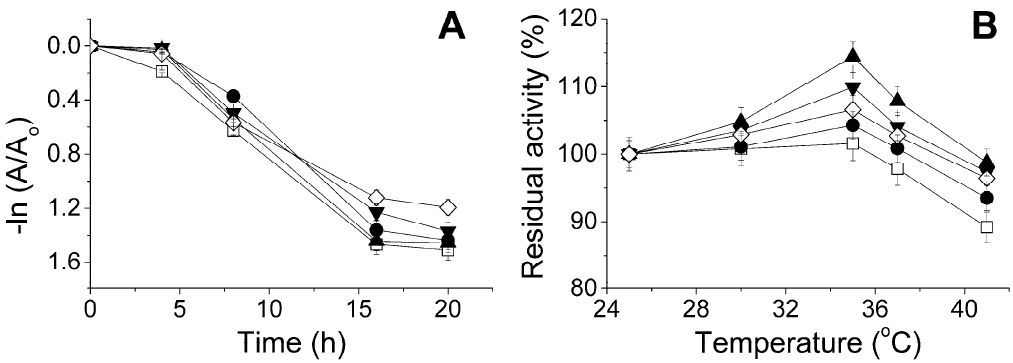
Figure 7. Thermal inactivation of lactonase activity of His 6 -OPH at pH 7.4 as a function of ( A ) time of exposure at 37 °C; and ( B ) temperature of the environment upon exposure for 15 min in the absence ( □ ) and presence of ampicillin ( ● ), gentamicin ( ▼ ), kanamycin ( ▲ ), and rifampicin ( ◊ ). Antibiotic and His 6 ‐ OPH concentration were 0.2 g ∙ L − 1 and 0.1 g ∙ L − 1 , respectively.